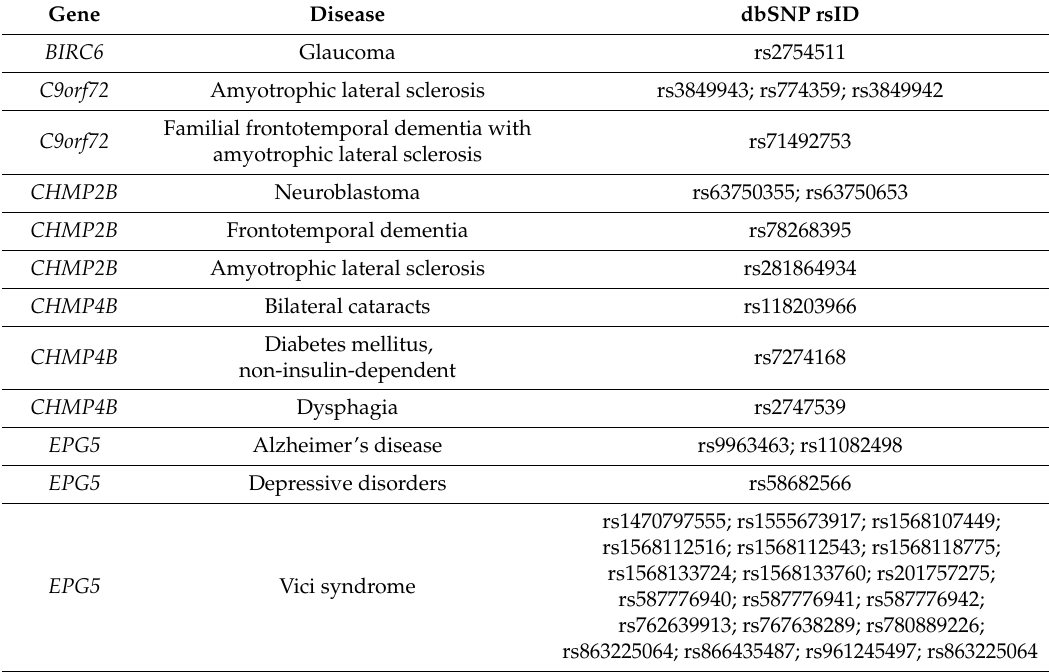
Figure 8. Different cellular machineries (including the HOPs and ESCRT complexes) and effectors (like motor proteins, as well as members of the SNARE or Rab family proteins) are involved in autophagosome transport and maturation, as well as in their fusion with lysosomes. Table 6. Clinically relevant SNPs in cellular machineries involved in autophagosome-lysosome fusion. Gene